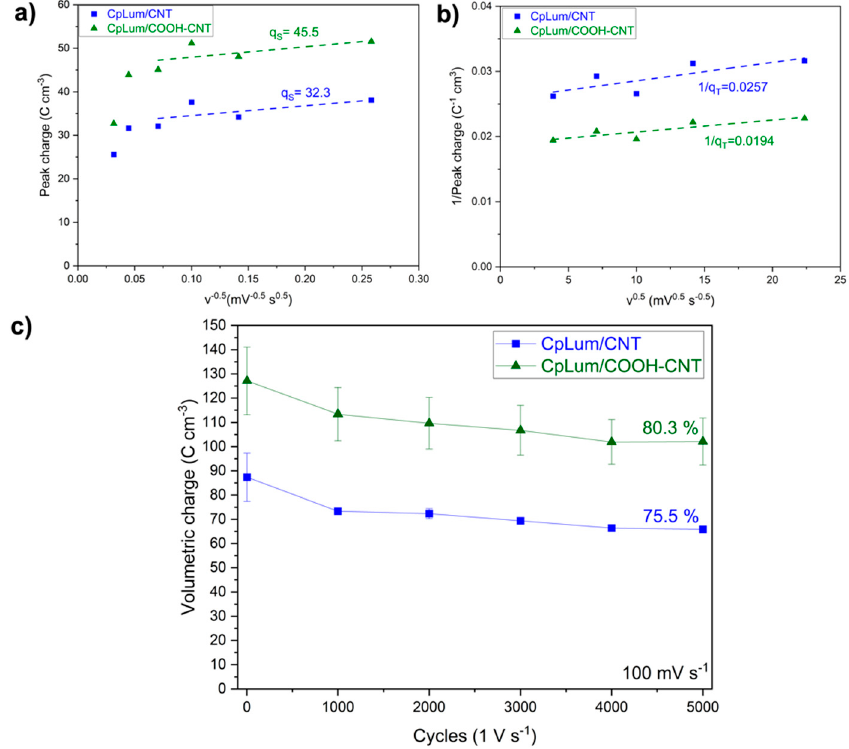
Figure 7. Comparing CpLum/CNT and CpLum/COOH-CNT ( a ) inverse peak charge vs. v 0.5 , ( b ) peak charge vs. v − 0.5 , ( c ) comparison of CpLum/CNT vs. CpLum/COOH-CNT using volumetric charge after cycling 5000 cycles at 1 V s − 1 , with measurements of 100 mV s − 1 at 1000 cycle Table 4. Summary of surface- and diffusion-controlled contributions to peak charge for CpLum/CNT and CpLum/COOH-CNT.